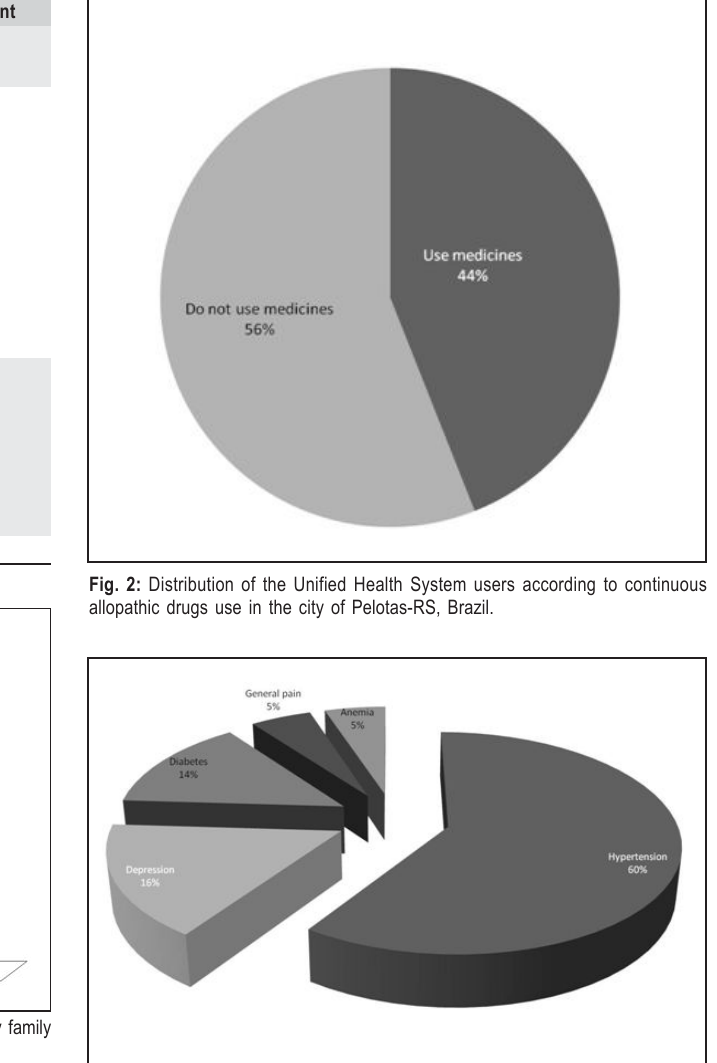
Table 2. Characterization of the sample.